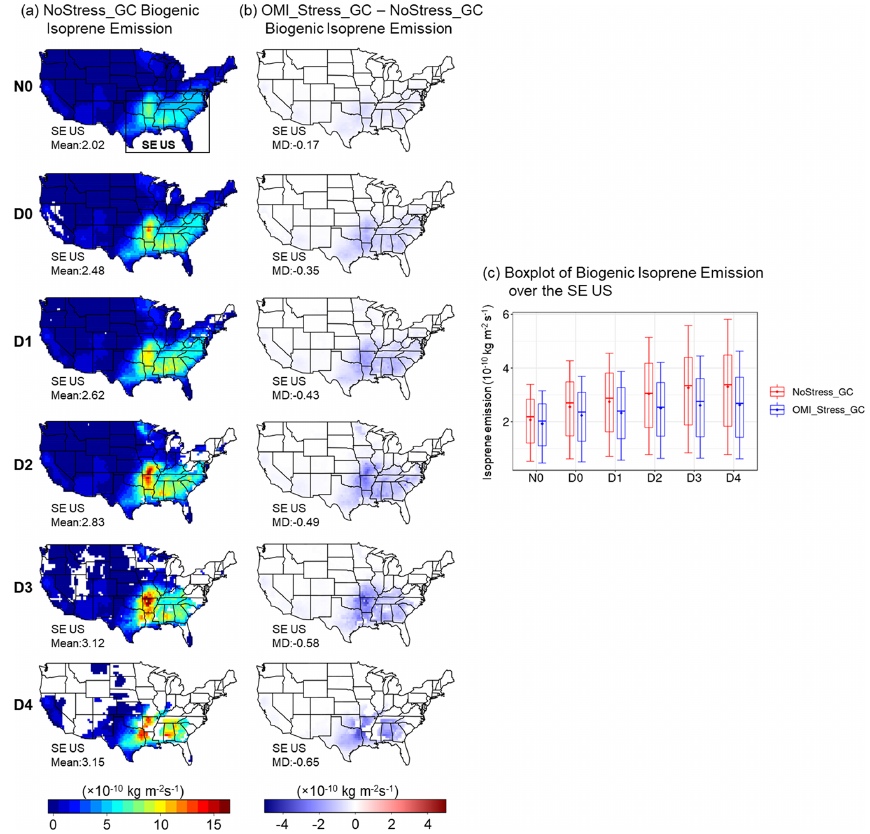
Figure 9. Simulated biogenic isoprene emissions during JJA 2005–2017 by USDM dryness category for NoStress_GC (a) and OMI_Stress_GC minus NoStress_GC (b) as well as the statistical distributions of the SE US isoprene emissions between the two simu- lations (c) . Numbers in the bottom left-hand corner of panel (a) indicate the SE US (black box) regional mean of biogenic isoprene emissions for NoStress_GC, whereas they indicate the mean difference (MD) between OMI_Stress_GC and NoStress_GC in panel (b)